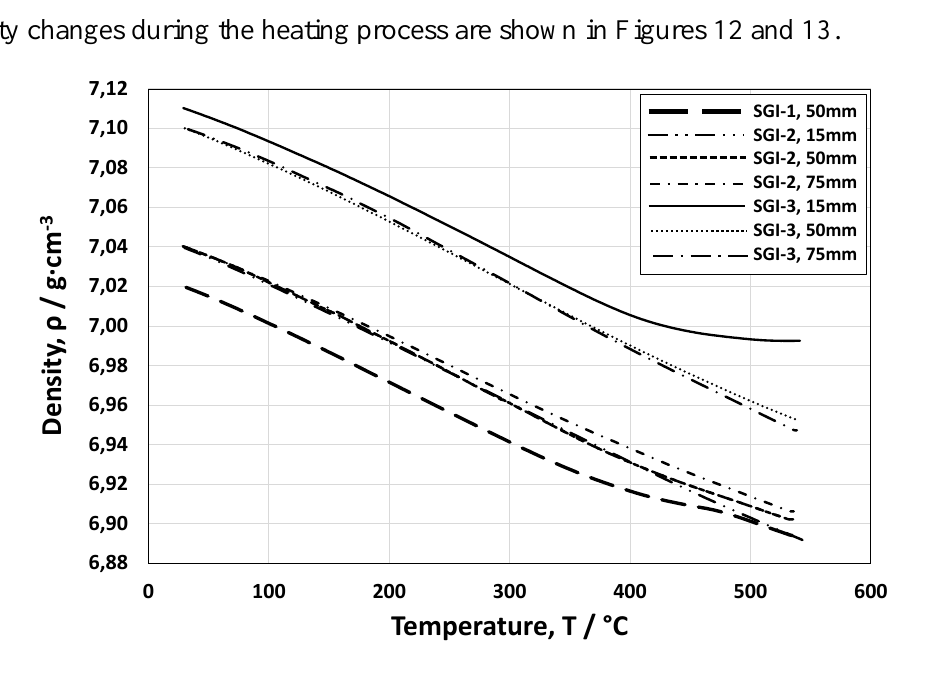
Figure 12. Density of the SGI as a function of temperature (during heating cycle).